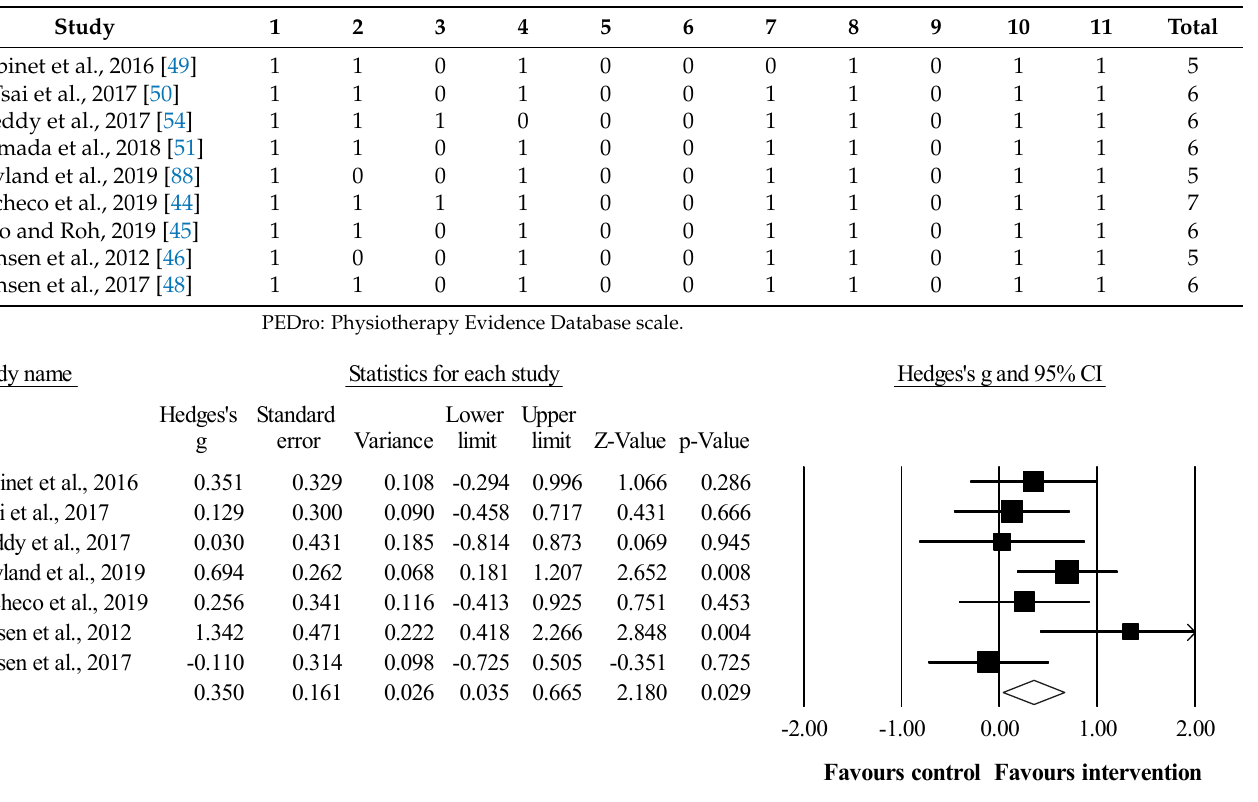
Figure 2. Forest plot of effects on working memory. Values shown are effect sizes (Hedges’s g) with 95% confidence intervals. The size of the plotted squares reflects the statistical weight of the study [44,46,48–50,54,88].